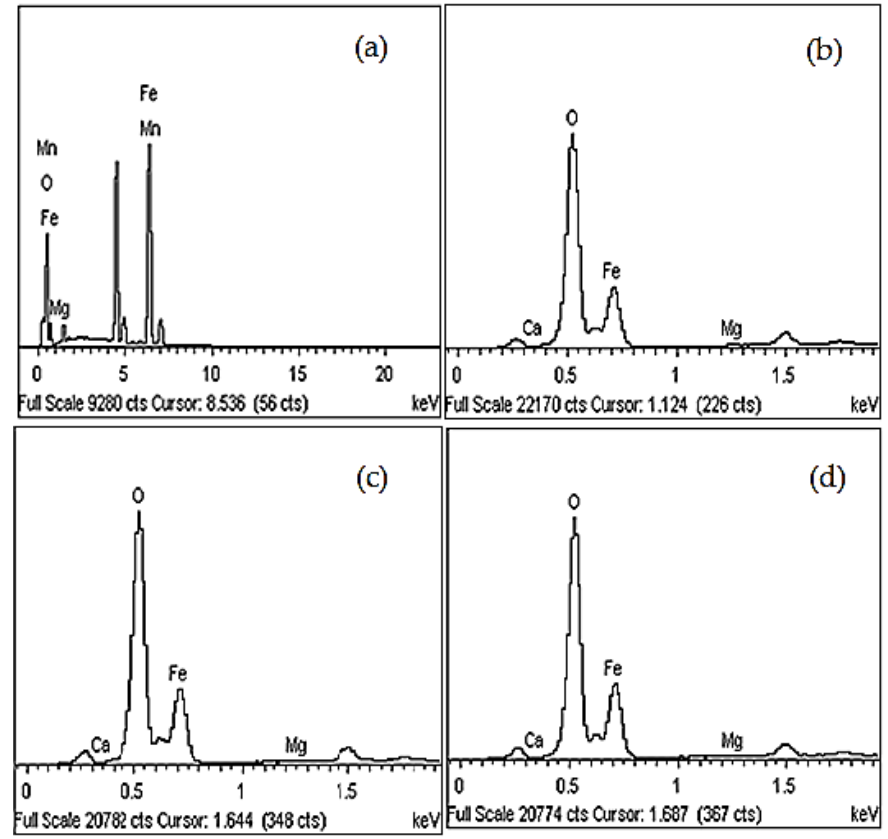
Materials 2019 , 12 , 1696 Figure 5. EDX spectra of recycled α -Fe 2 O 3 after ( a ) 0 h, ( b ) 8 h, ( c ) 10 h, and ( d ) 12 h of milling time. Figure 5. EDX spectra of recycled α -Fe 2 O 3 after ( a ) 0 h, ( b ) 8 h, ( c) 10 h, and ( d ) 12 h of milling time. Table 2. Quantitative analysis of recycled α -Fe 2 O 3 particles.